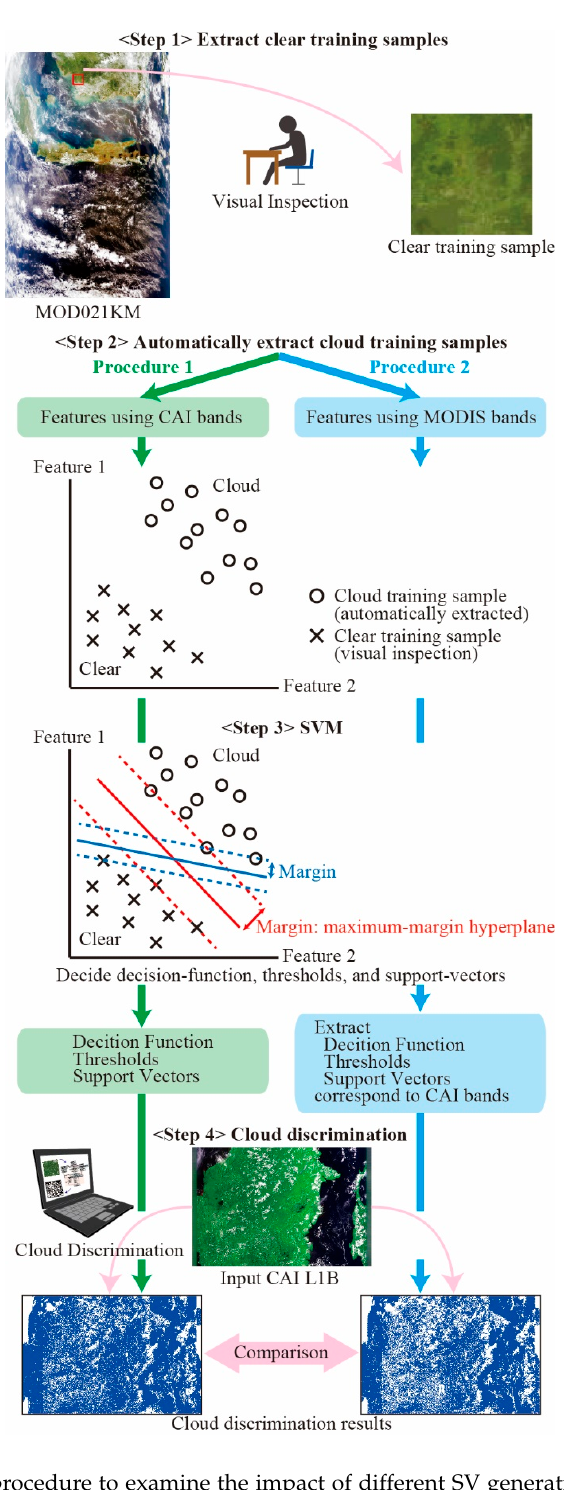
Figure 2. Analytical procedure to examine the impact of different SV generation procedures using MODIS data.